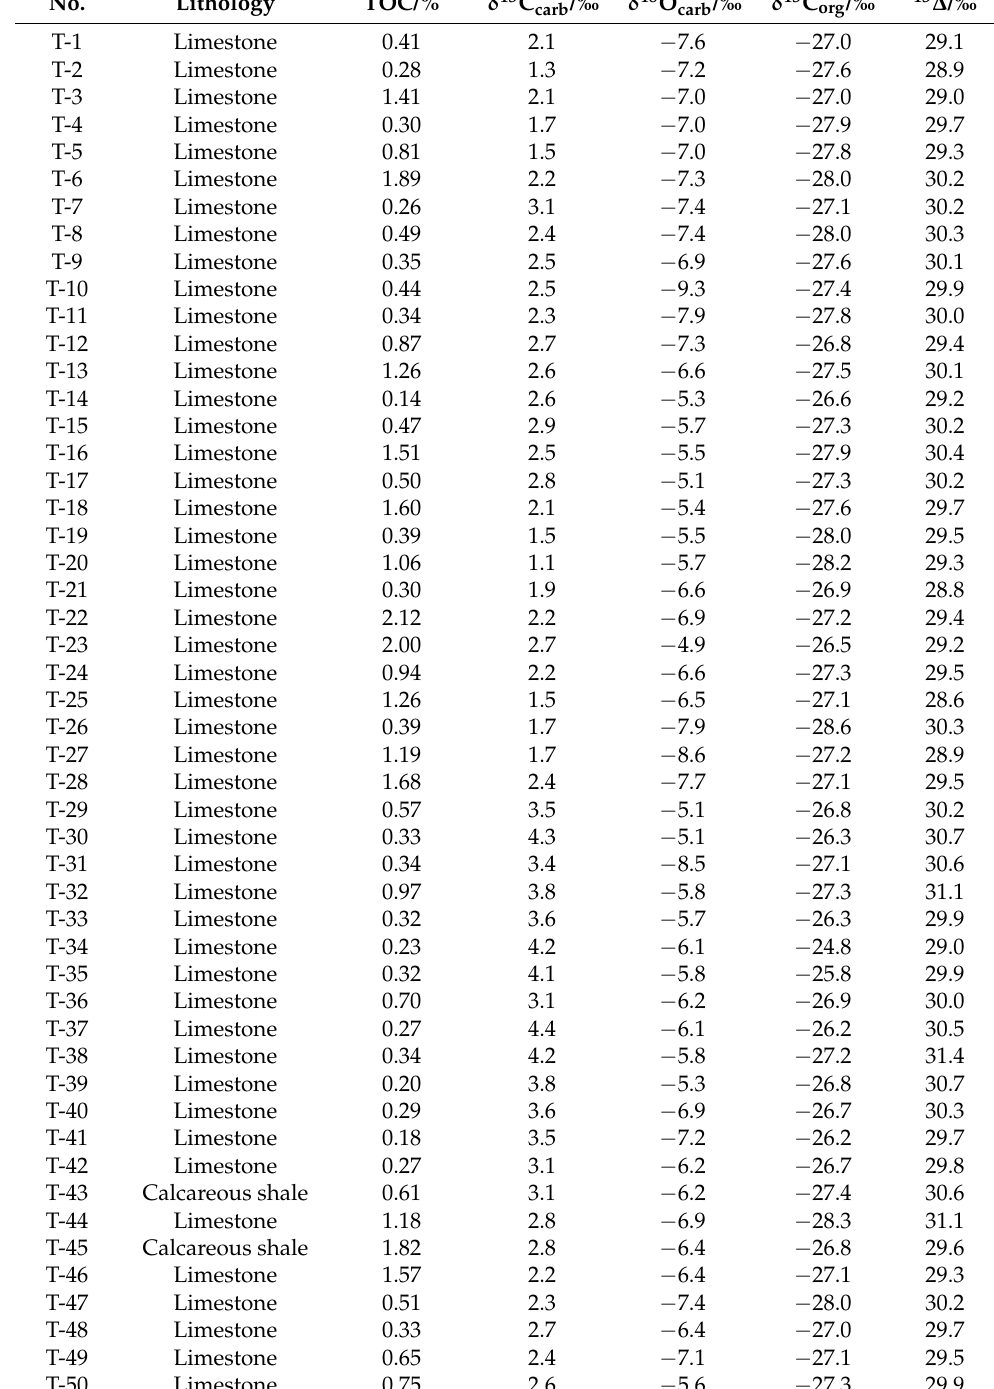
Table 1. TOC variations and paired inorganic and organic carbon isotopic data across the Kungurian Marine carbonate rocks from the Putaoling section,